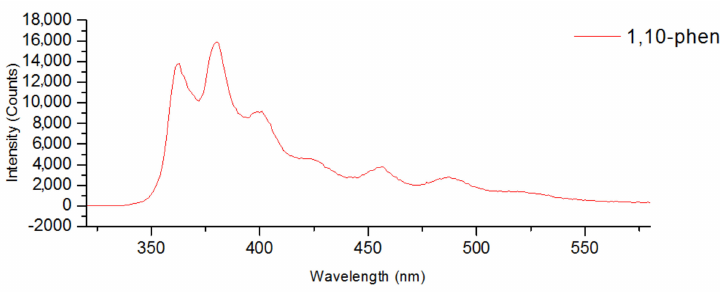
Figure 21. Emission spectrum of